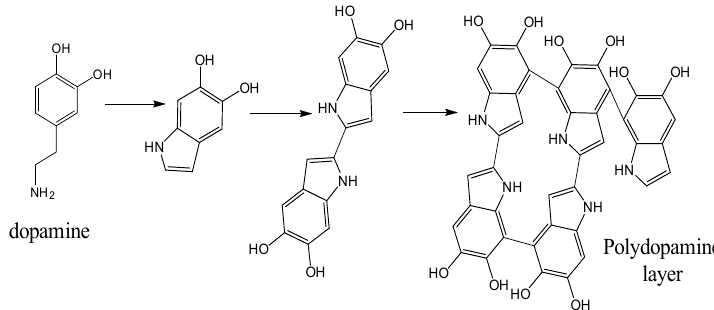
Figure 3. The formation process of the polydopamine layer.